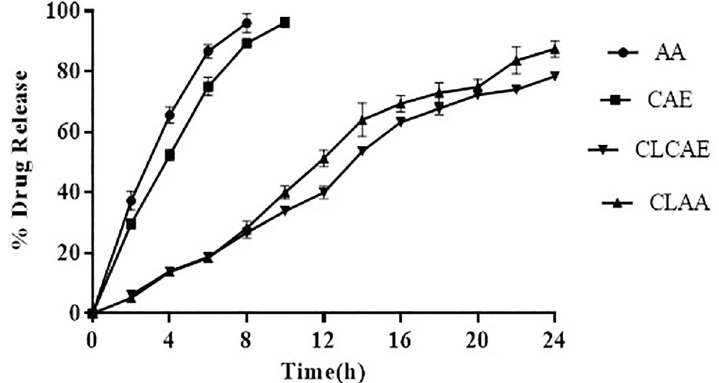
Figure 6. In vitro drug release of AA, CAE, CLCAE, CLAA (n=3).